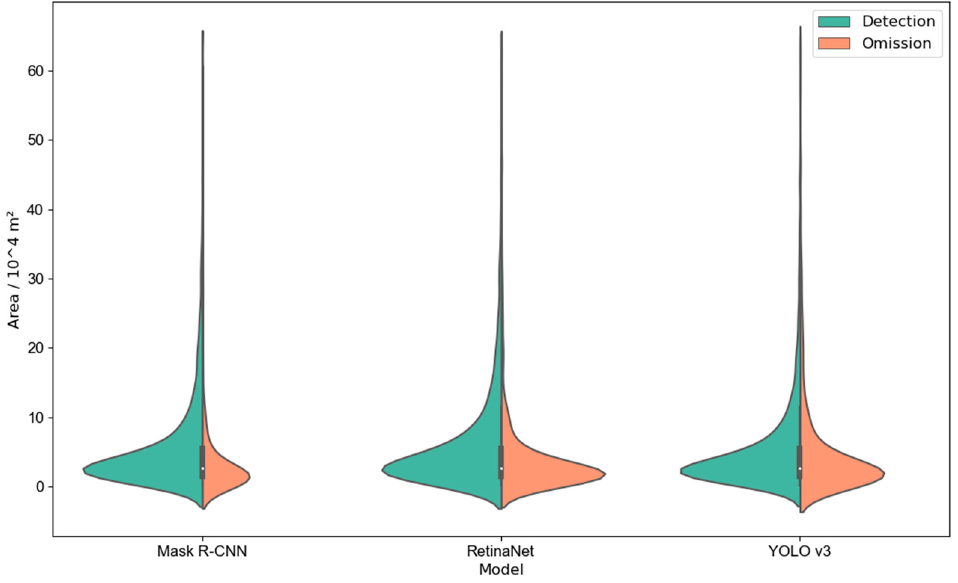
Figure 7. The violin plots of the landslide area of detection and omission in the test dataset for the three models. three